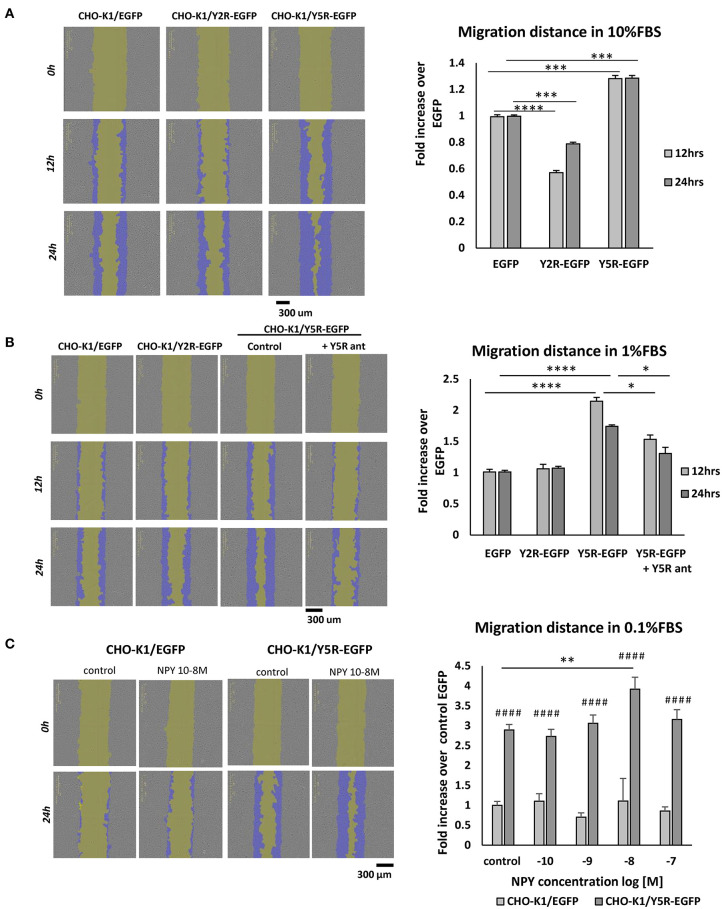
In CHO-K1 cells, overexpression of Y5R promotes cellular migration, while Y2R inhibits cell motility. Migration of CHO-K1 cells transfected with Y2R or Y5R fused to EGFP or with EGFP alone, measured by a wound healing assay with IncuCyte ZOOM live-cell imaging system analysis. Representative images captured by the IncuCyte software followed by quantitative analyses are shown. (A) Cell migration in 10% FBS. (B) Cell migration in 1% FBS. The migration of CHO-K1/Y5R-EGFP cells measured in the presence or absence of Y5R antagonist (CGP71683, 10−6 M). (C) Migration of CHO-K1/EGFP and CHO-K1/Y5R-EGFP cells in response to NPY (10−10-10−7 M) in 0.1% FBS. (A–C) *p < 0.05; **p < 0.01; ***p < 0.001; ****p < 0.0001 as shown or ####p < 0.0001 vs. CHO-K1/EGFP under the same conditions by one-way ANOVA followed by Tukey's test; mean ± SEM from three independent experiments, n = 3–32 each.